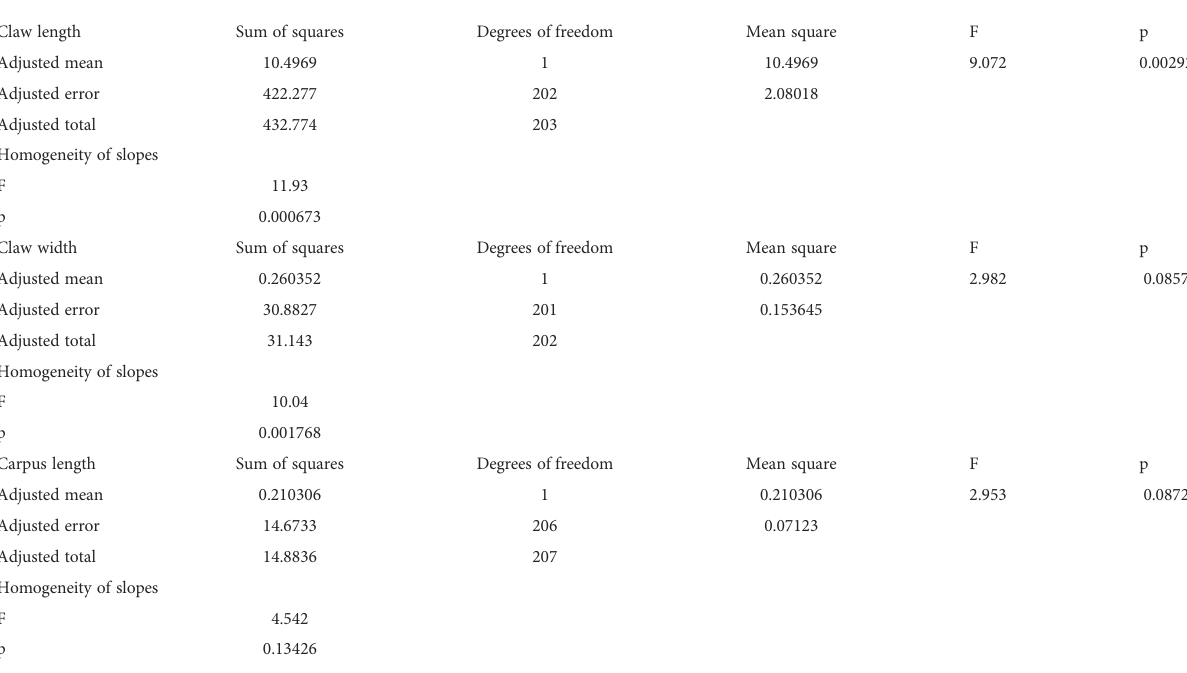
TABLE 2 ANCOVA outcomes: Sum of squares, degrees of freedom, mean squares, F values, p values, and homogeneity of slopes (F value and p value) for the relationship of claw length, claw width, and carpus length (second pereopod) with carapace length by sex in (adult males and females) of Kiwa puravida from Mound 12, Costa Rican Paci fi c margin. ANCOVA: Male and female